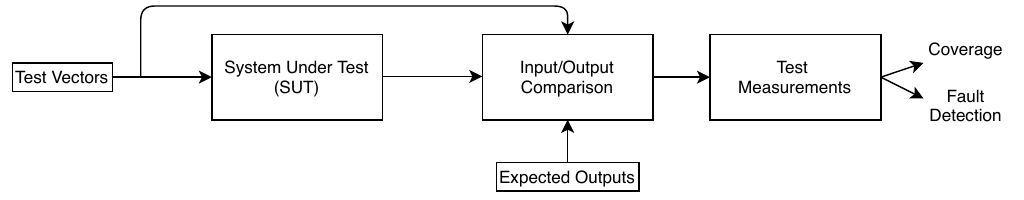
Figure 2. An overview of the test generation process for a SUT.